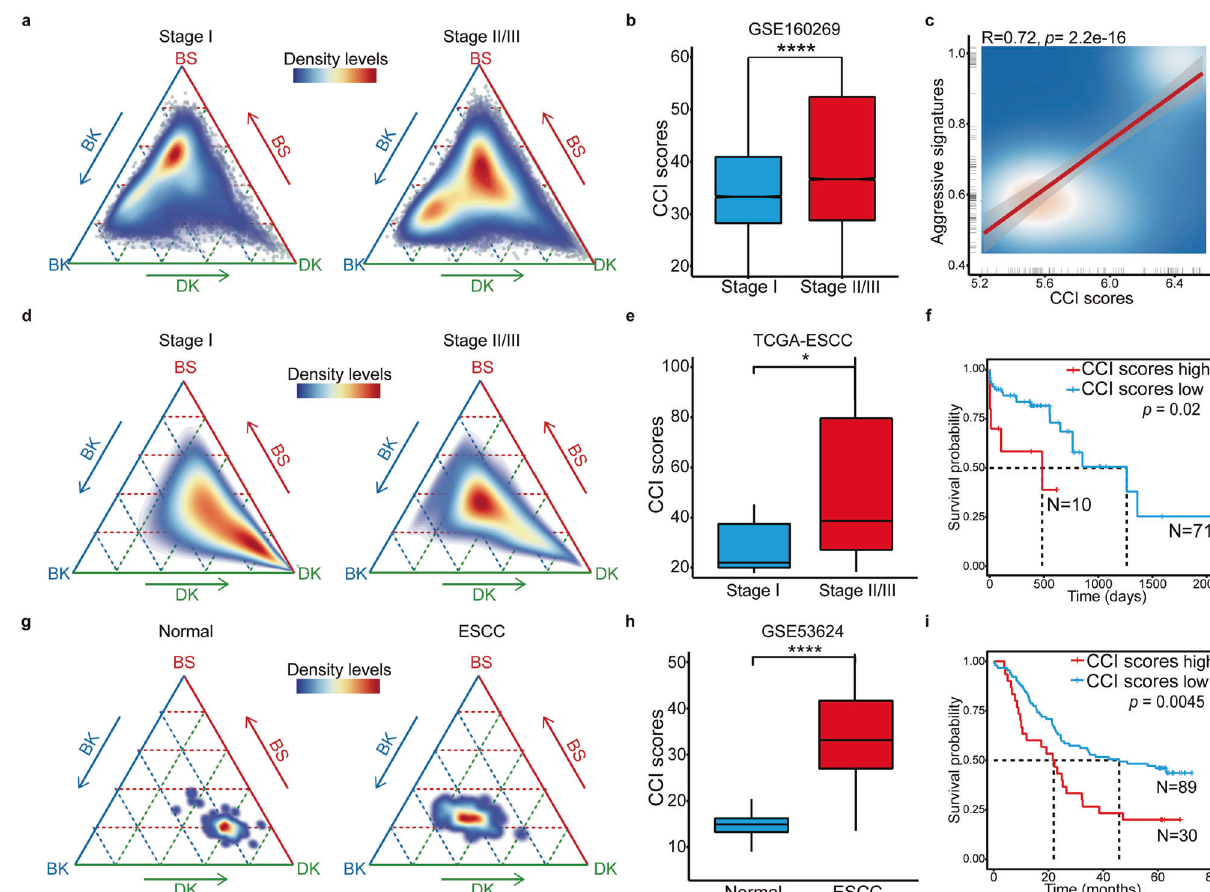
the control organoids were close to the corner of BK, those with Tpm4 overexpression moved toward the center (Supplementary Fig. S6b and Supplementary Table 8). And the CCI scores of Tpm4 overexpressed organoids were signi fi cantly higher than those of the control ones (Fig. 3k). Taken together, TPM4 promoted CCI in esophageal epithelial cells. TPM4 promotes ESCC metastasis in mice We further con fi rmed the function of TPM4 in ESCC in vivo. Tpm4 was overexpressed in mouse ESCC organoids and then subcuta- neously transplanted into recipient mice with control ESCC organoids on the other side. Tumors with Tpm4 overexpression grew signi fi cantly faster than control tumors, measured by fl uorescence living imaging (Supplementary Fig. S7a, b). Histology analyses suggested that Tpm4 tumors were a more advanced stage than control ESCC, indicating a higher nuclear-to- cytoplasmic ratio, denser nuclei, and less differentiation (Supple- mentary Fig. S7c). And there were also signi fi cantly more Ki67 + tumor cells in Tpm4 overexpression ESCC than control tumors Signal Transduction and Targeted Therapy (2022)